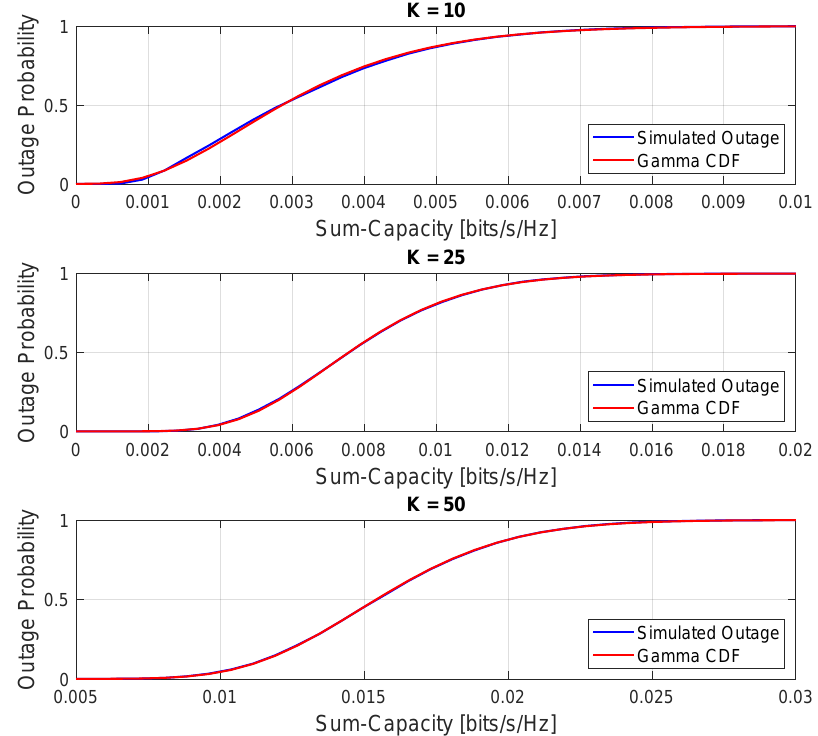
Figure 11. Comparison between the approximated and simulated outage probabilities in the low-SNR regime and favorable propagation